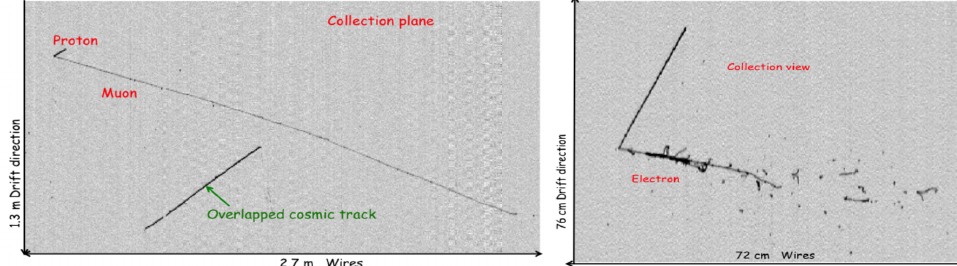
Figure 14. ( Left ): A fully contained ν µ CC quasi-elastic event from the BNB beam. ( Right ): An electron neutrino event from the NuMI